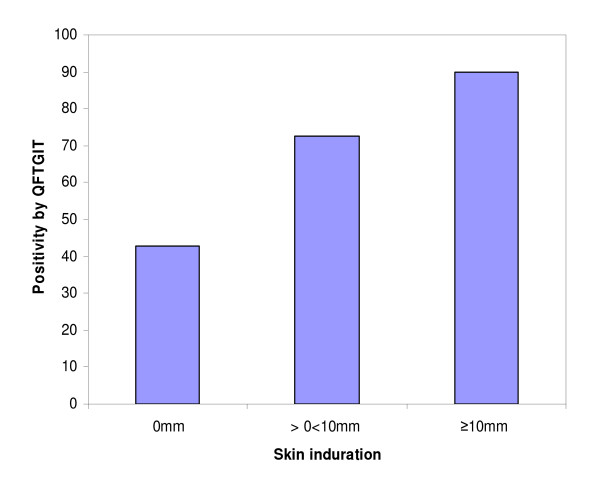
The trend of proportion of positivity by QFTGIT against the skin test indurations. Whole blood samples were collected from study participants directly into tubes containing TB-specific antigens, mitogen and nil. The samples were incubated for 24 hours at 37°C, plasma was collected and IFNγ assay was performed using ELISA. The results were interpreted as positive, negative or indeterminate on the basis of the manufacturer's recommended cut-off value (IFN-γ ≥ 0.35 IU/ml) using QFTGIT analysis software developed by the company. Tuberculin skin test (TST) was also performed by administrating 0.1 ml (2T.U/0.1 ml) tuberculin PPD RT23 (Statens Serum Institute, Copenhagen, Denmark) intradermally in the middle of the left forearm. The diameter of the indurations was measured transversely after 48-72 h using a ball-point pen and flexible plastic ruler. The subjects were categorized in to three groups based on the size of skin test induration (0 mm, >0 < 10 mm and ≥ 10 mm) and the positivity by QFTGIT was compared for the three groups.